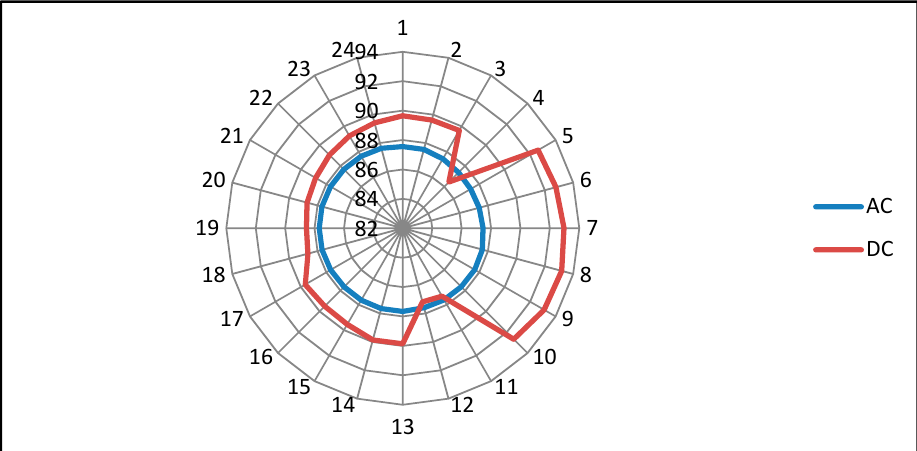
Figure 4. System efficiency for 24 hours of the AC and DC system.